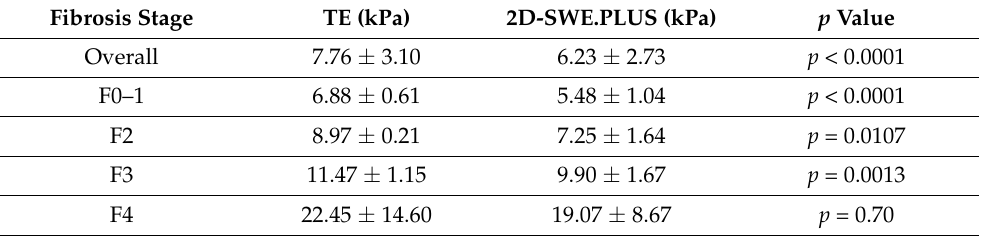
Table 2. Differences between mean LSMs by TE and 2D-SWE.PLUS in different fibrosis stages. Fibrosis Stage TE (kPa) 2D-SWE.PLUS